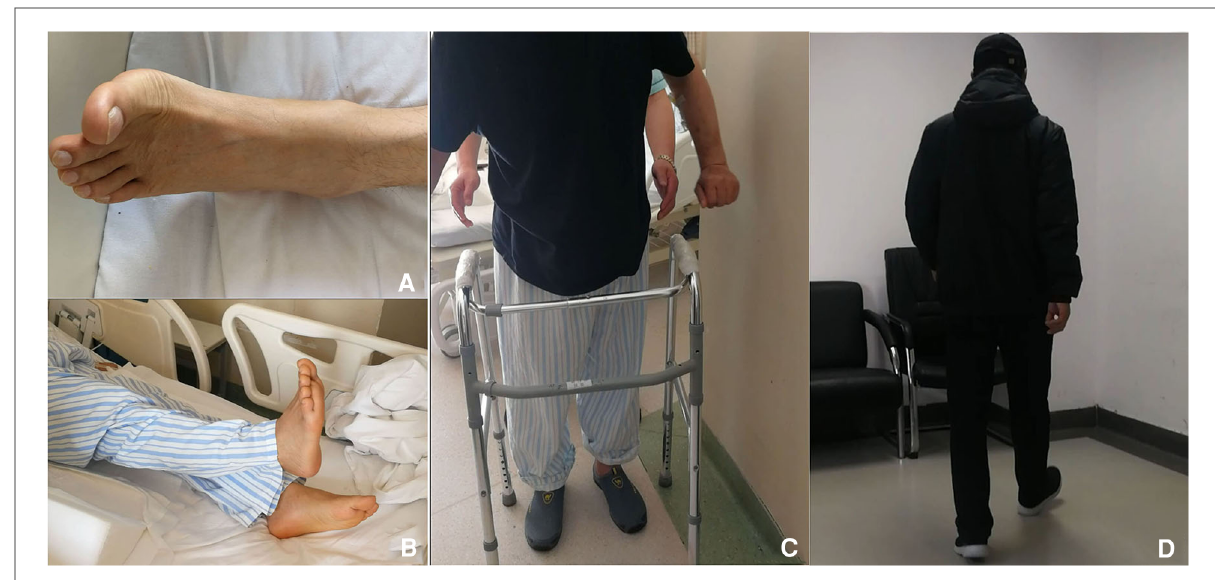
FIGURE 4 Follow-up postoperatively. ( A ) Dorsal fl exion of left big toe could be detected in the surgery morning. ( B ) Right lower limb raising with right ankle at neutral position 1 day postoperatively. ( C ) The patient could walk freely for 5 m 7 days postoperatively. ( D ) Free walking 4 months